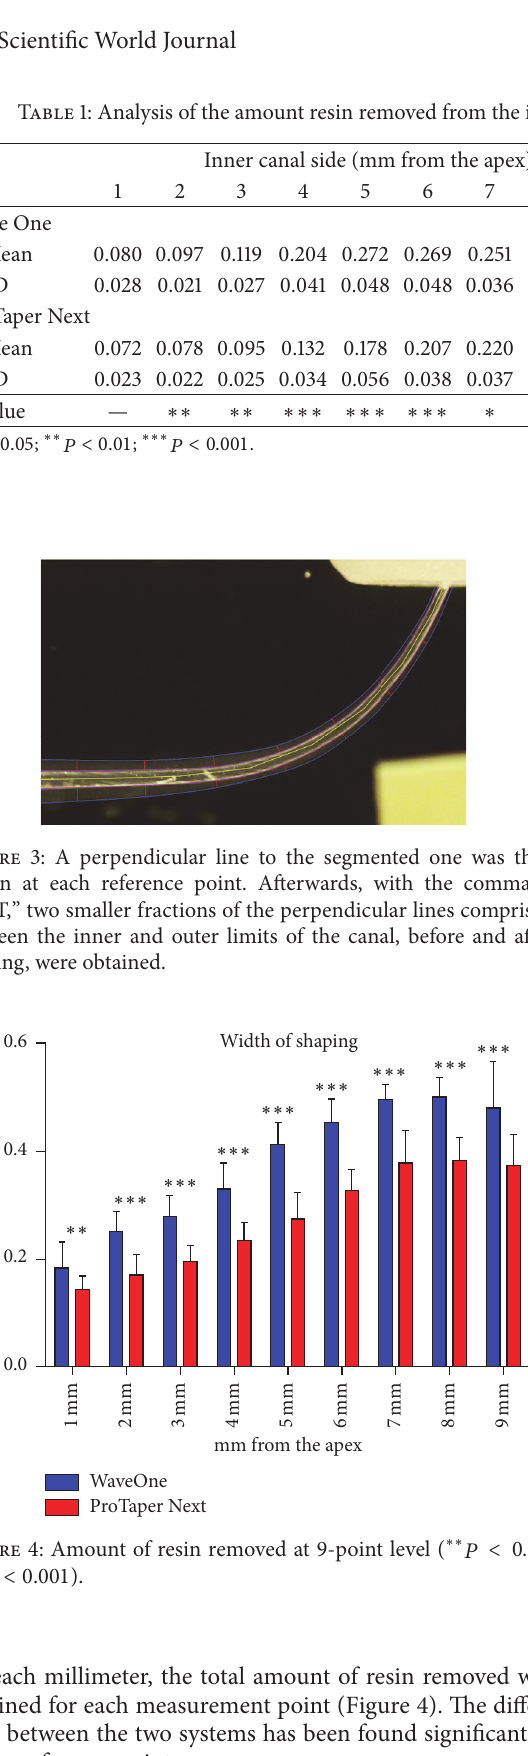
for each millimeter, the total amount of resin removed was obtained for each measurement point (Figure 4). The differ- ence between the two systems has been found significant in all the reference points.